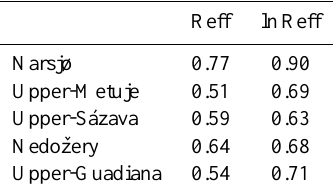
using Thiessen polygons. An altitude correction was applied Table 2. Nash-Sutcliffe values per